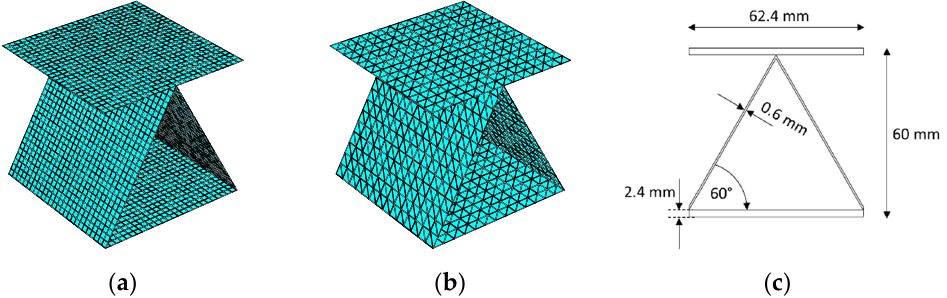
Figure 11. Representative shell elements of saw tooth geometry with quadrilateral mesh (single period): ( a ) model with a fine 4-node mesh; ( b ) model with a coarse 3-node mesh; ( c ) model geometry.